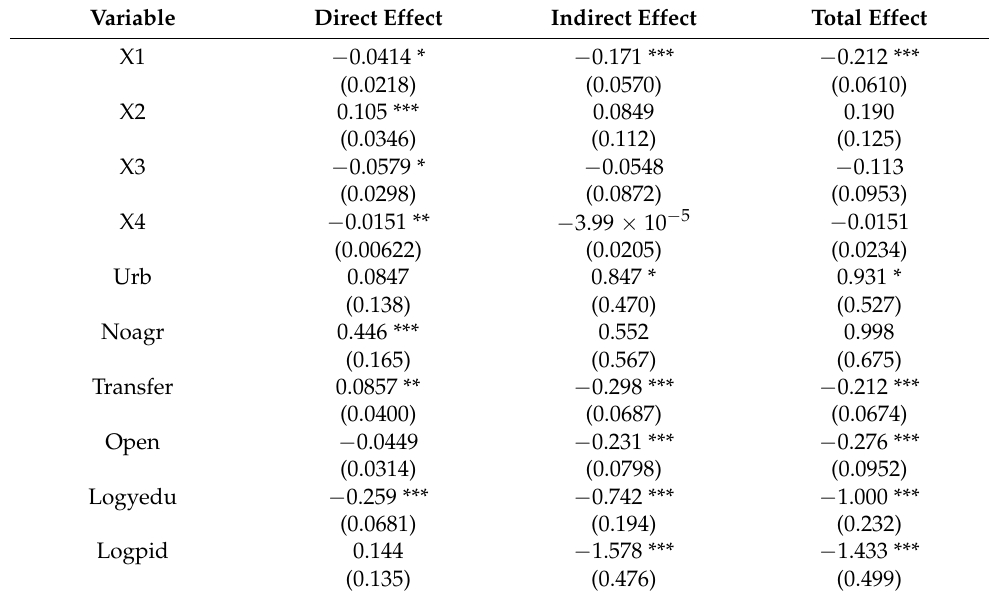
Table 7. Direct, indirect, and total effects for the spatial fixed